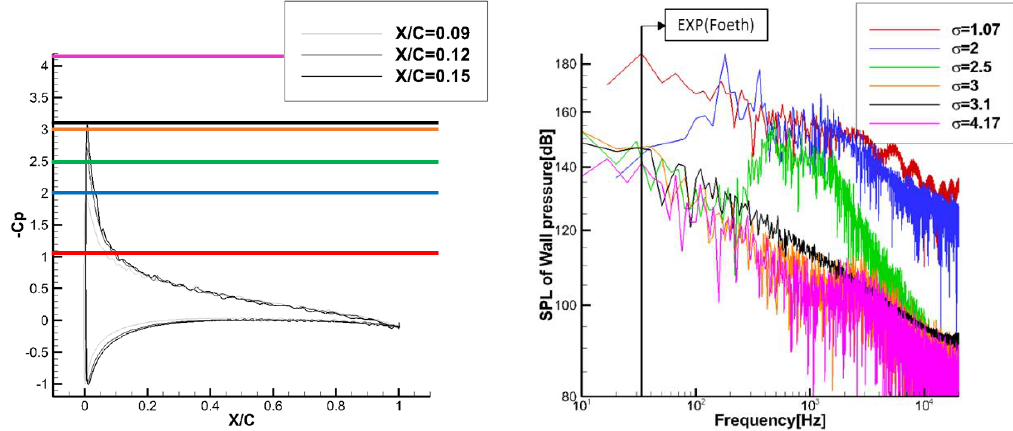
Figure 13. Comparison of LES, DES, and RANS models; SPL of wall pressure according to cavitating flow and wetted flow.